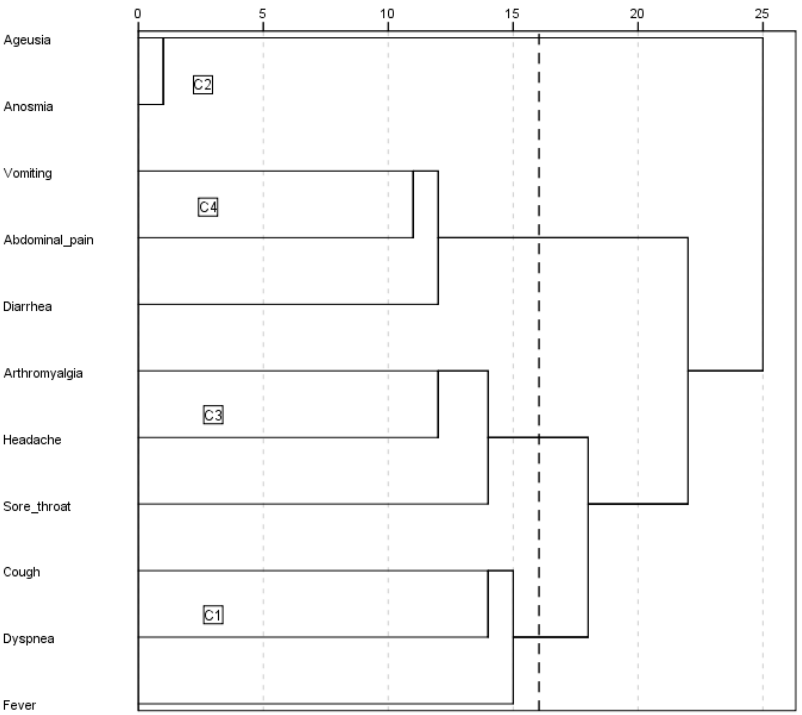
Figure 1. Dendrogram. Clusters 1 to 4. Table 2. Symptoms and physical examination between clusters. Table 3. General data and lab tests between